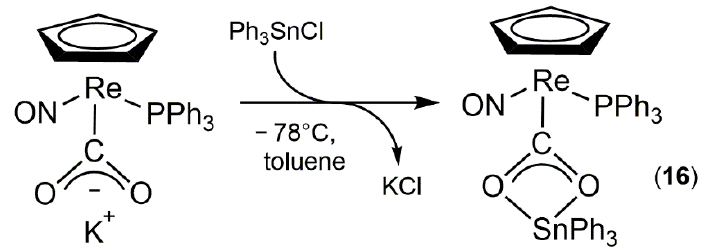
Scheme 23. Reaction scheme leading to Compound 16 , data from [72].